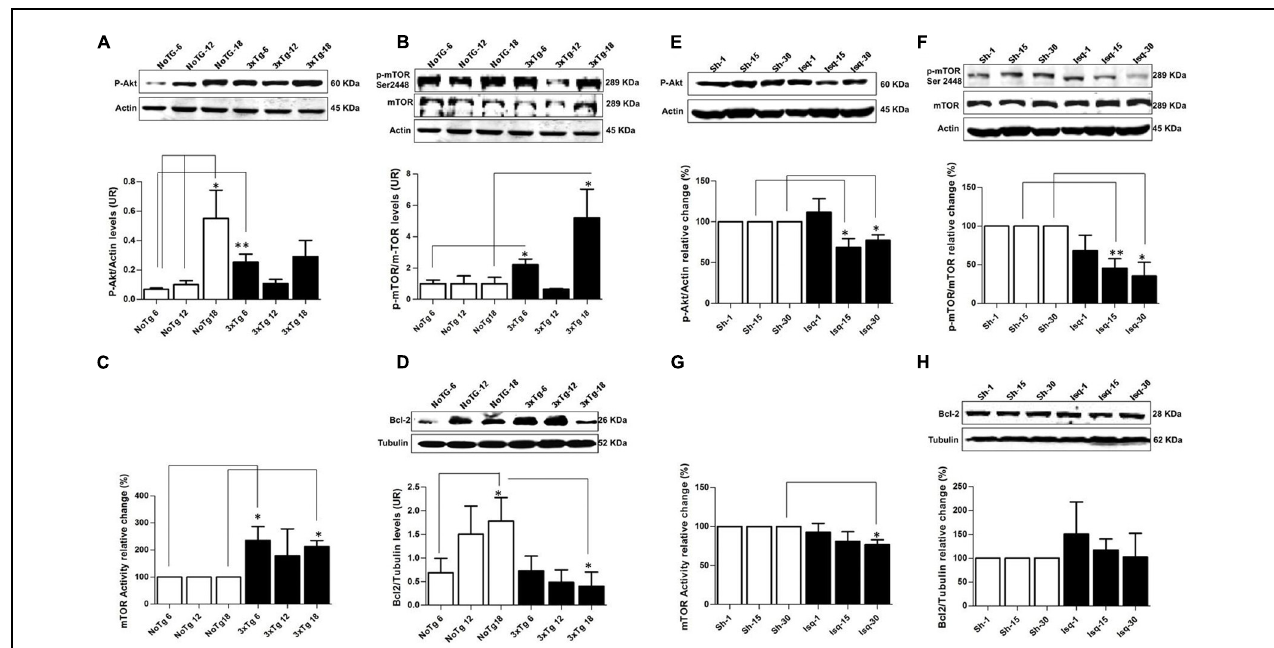
FIGURE 2 | Altered p-AKT/p-mTOR activation in the cerebral cortex of 3xTgAD mice compared with cerebral ischemia in rats. Representative bands from SS-Cx lysates of 3xTgAD and ischemic rats were evaluated by Western blotting. (A) p-Ser473 Akt protein levels increased in NoTg mice at 18 months ( p ≤ 0.005) compared with t NoTg mice at 6 and 12 months. Also, p-Ser473 Akt protein levels increased at 6 months in 3xTg-AD ( p ≤ 0.0045). (B) p-Ser2448 mTOR protein levels increased at 6 ( p ≤ 0.0150) and 18 ( p ≤ 0.0339) months in 3xTgAD mice, (C) mTOR activity increased at 18 months ( p ≤ 0.017), (D) Bcl-2 protein levels Increased in NoTg mice at 18 months ( p ≤ 0.045), and there was a reduction in the levels of Bcl-2 in the